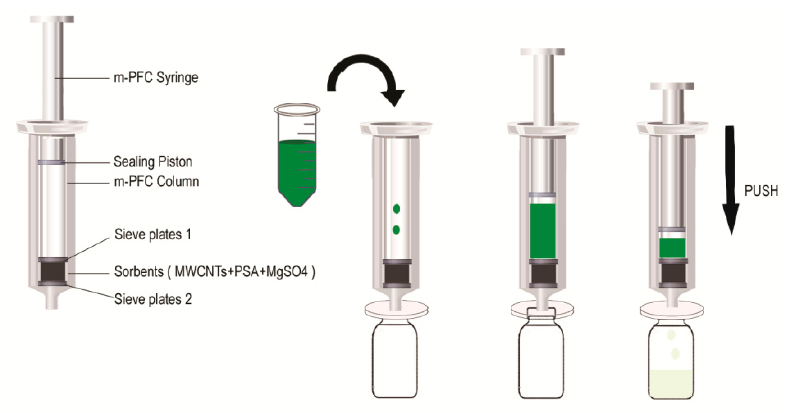
Figure 1. Schematic diagram of multi-plug filtration cleanup (m-PFC) syringe and cleanup procedure diagram.